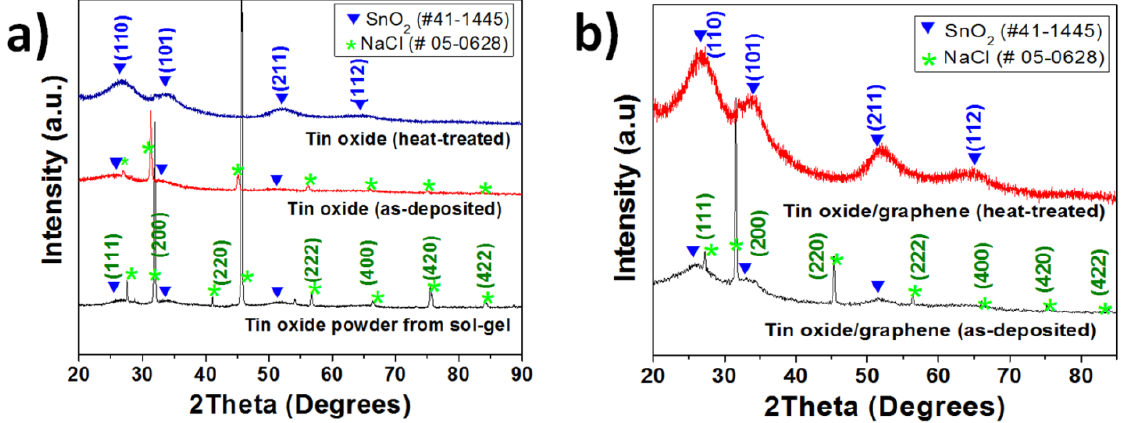
Figure 2. X-ray diffraction patterns of ( a ) tin oxide—the peaks for tin oxide powder obtained from sol-gel, the as-deposited and heat-treated tin oxide are shown; and ( b ) tin oxide/graphene composites—both as-deposited and heat-treated are